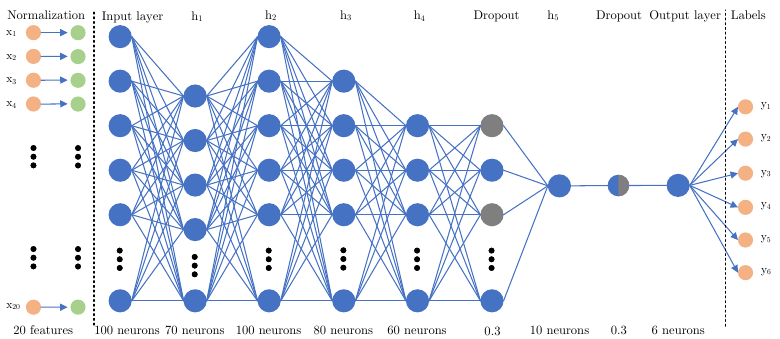
Figure 7. General scheme of the deep neural network